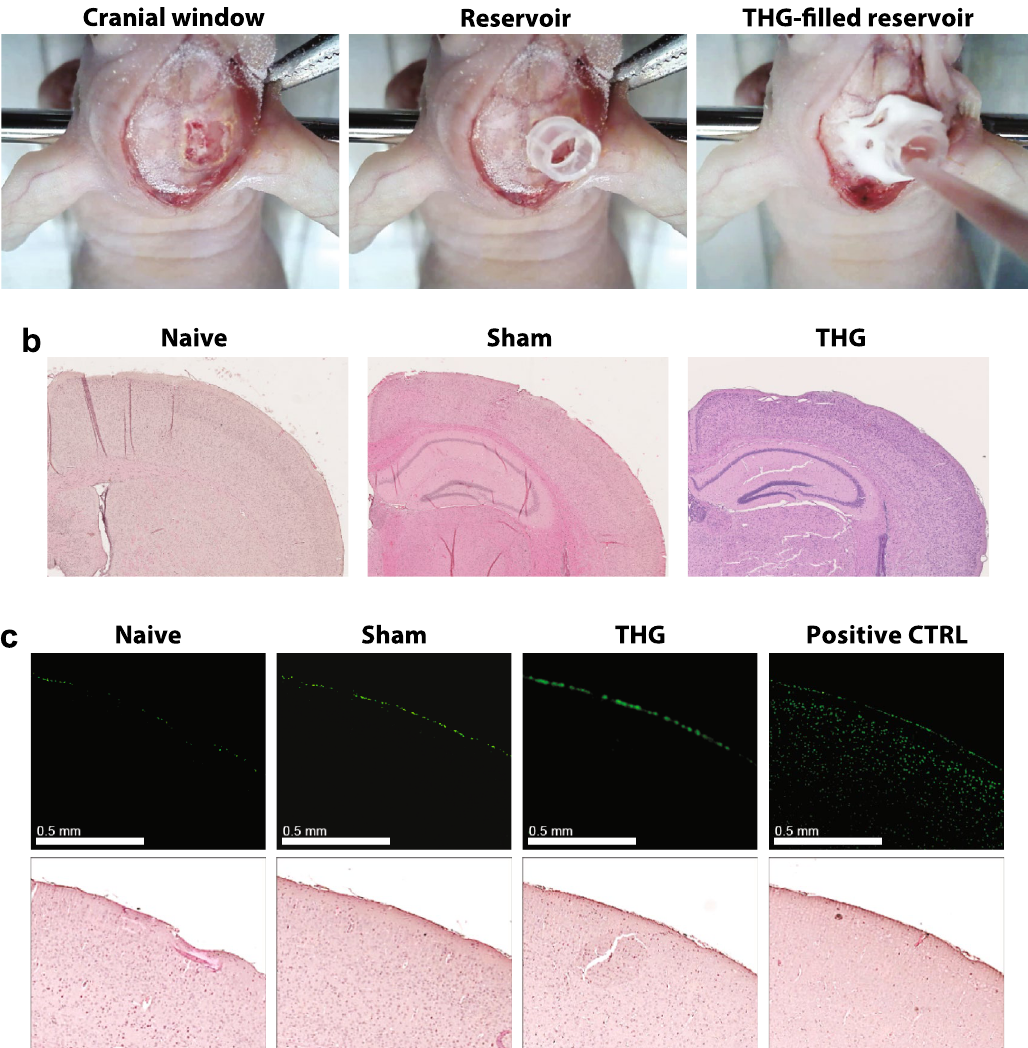
Figure 4. THG induced no toxic reaction after locally treatment of the brain tissue for 24 h. ( a ) A cranial window in the skull was created to expose the brain tissue for direct application of THG thermogel. To apply the gel, a customized bottomless plastic reservoir was fixed to the skull, filled with fluid gel (4 °C), closed and secured on the mouse head. ( b ) Representative images of histological investigation of brains from naïve, sham and THG-treated mice. H&E on coronal sections from each of experimental case revealed no major sign of adverse cellular and structural change. ( c ) TUNEL reactions on brains from naïve, sham and THG-treated mice (upper panel) and the same slides after H&E staining (lower panel). No apoptosis was detected in naïve, sham and THG-treated specimens. Positive control (CTRL) was obtained by treating the slices with DNase I.